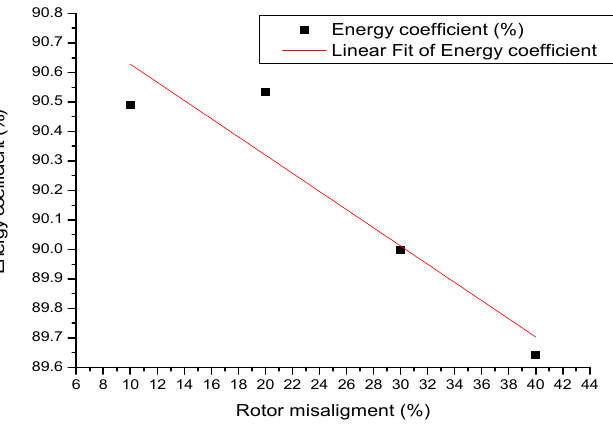
Figure 11. The relation between the energy coefficient and the level of the eccentric rotor.